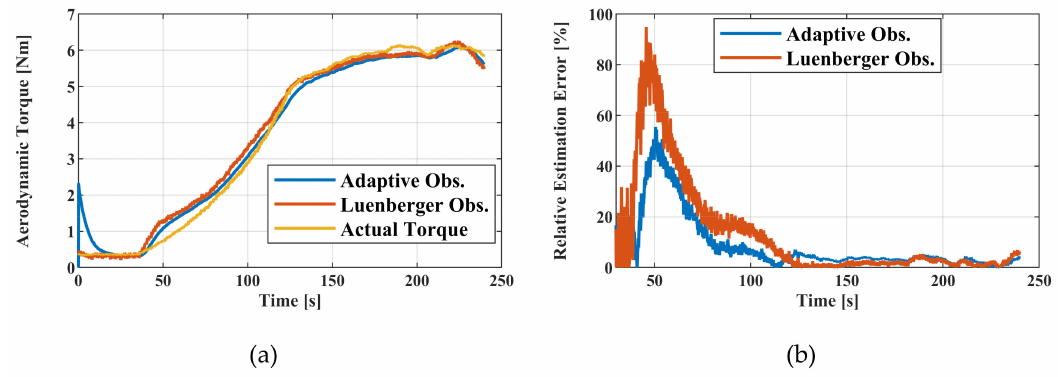
Figure 13. Aerodynamic torque: ( a ) actual and estimated aerodynamic torque; ( b ) relative (percentage) estimation errors.